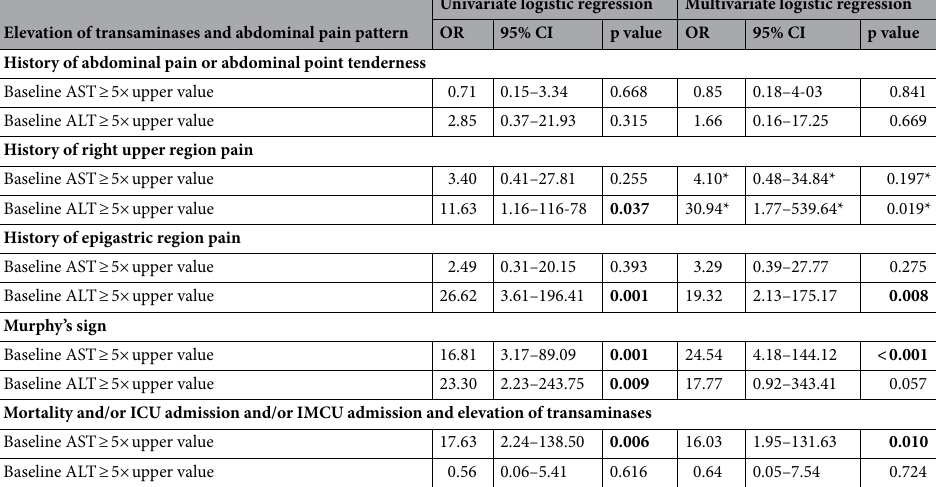
Univariate logistic